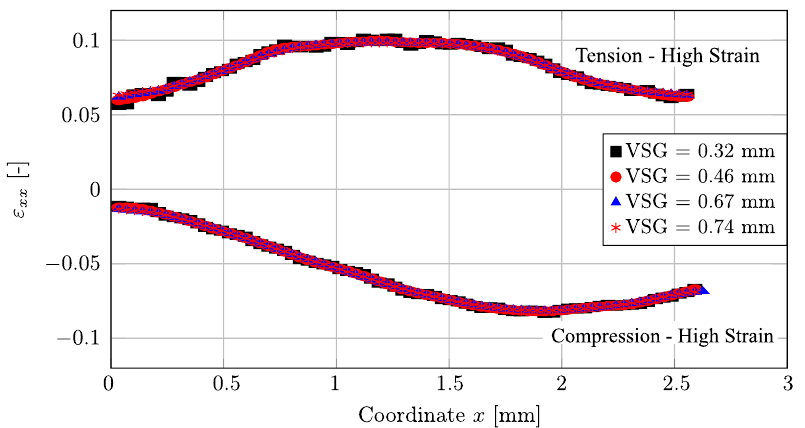
Figure 6. Evaluation of ε xx as a function of the coordinate x for several Virtual Strain Gauge (VVSG) values for both tension and compression